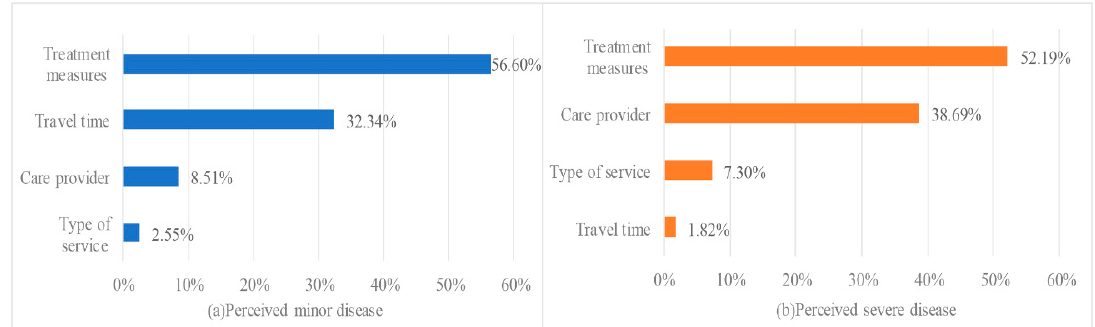
Figure 3. Relative importance of the attributes.